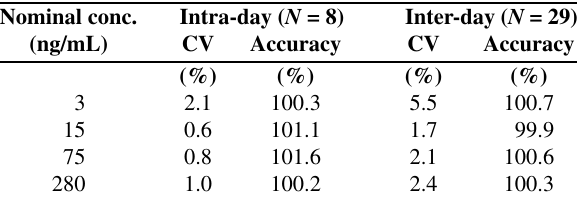
Table 3: Intra-day and inter-day accuracy and precision of cande- sartan determination in human plasma. Nominal